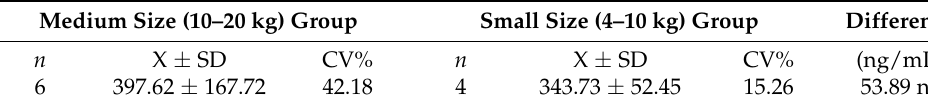
Table 1. Serotonin values in dogs depending on their size (ng/mL).